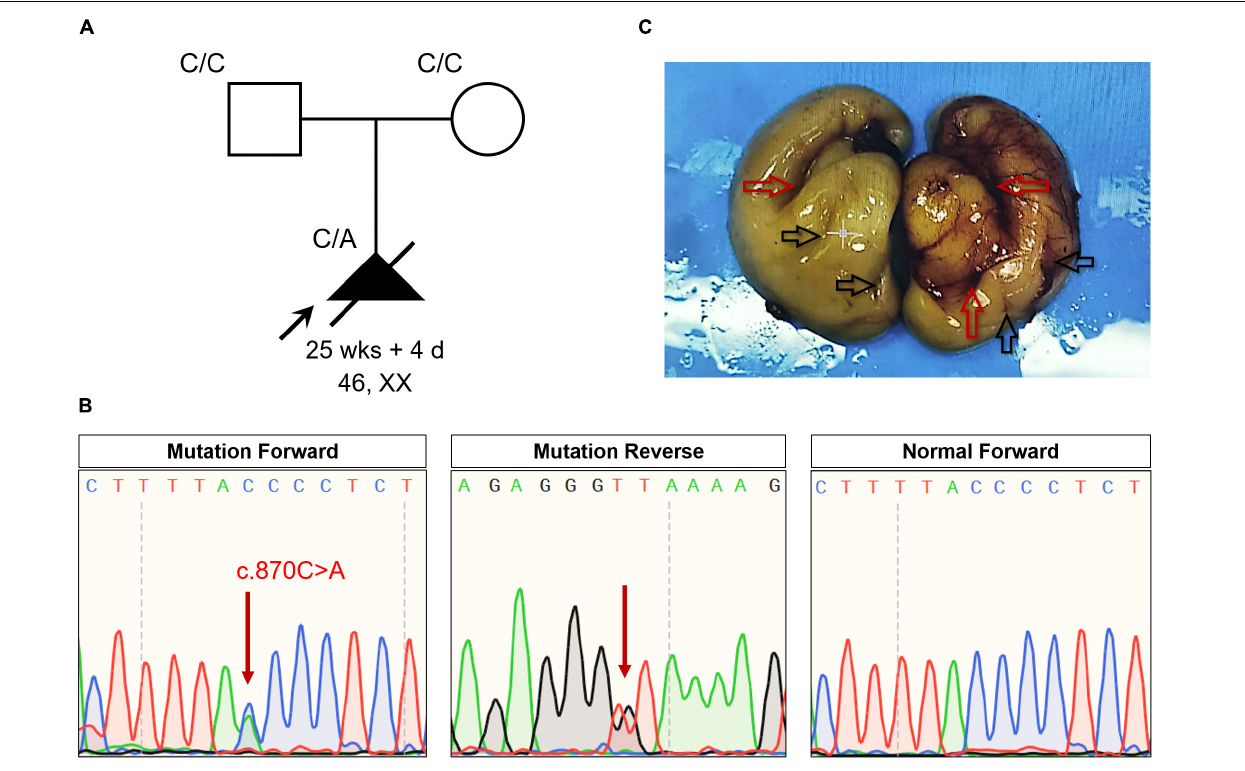
FIGURE 1 | (A) The pedigree of this family. Black indicates the affected fetus with lissencephaly and lung lobulation defects. white circles/squares are unaffected. Arrow indicates the proband. (B) Sequencing results of the NFIB mutation. Sequence chromatograms indicate the heterozygosity of the NFIB non-sense mutation